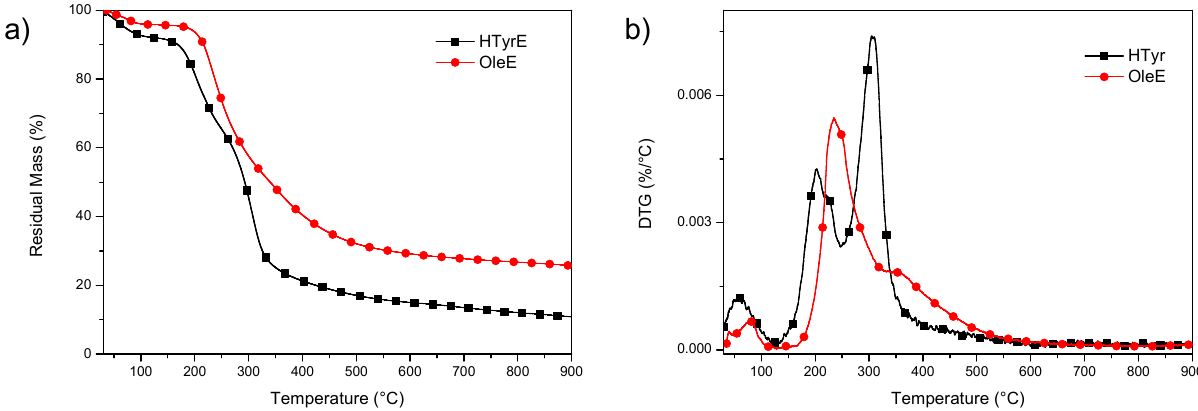
Figure 6. TG (residual mass) ( a ) and DTG (derivative weight loss) ( b ) curves for HTyrE and OleE.